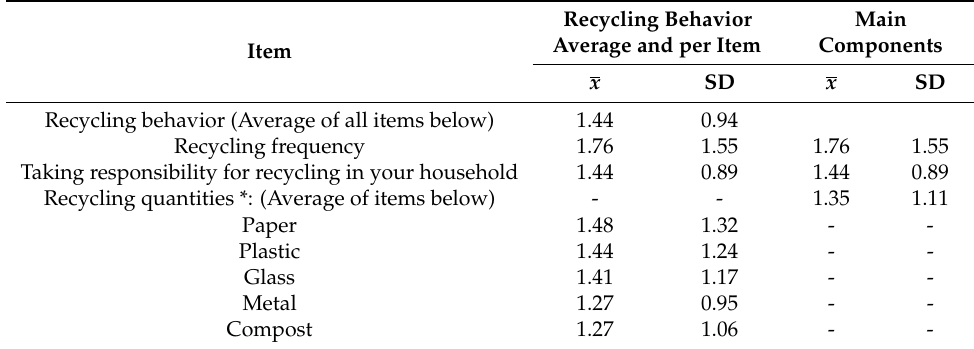
Table 2. Descriptive statistics for the recycling behavior measurement and the separate items that make up the